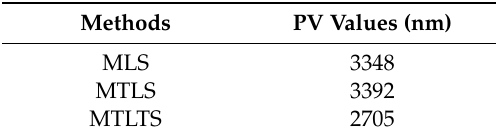
Figure 13. The error graphs processed by three methods. Table 7. The peak-to-valley (PV) values of three methods.